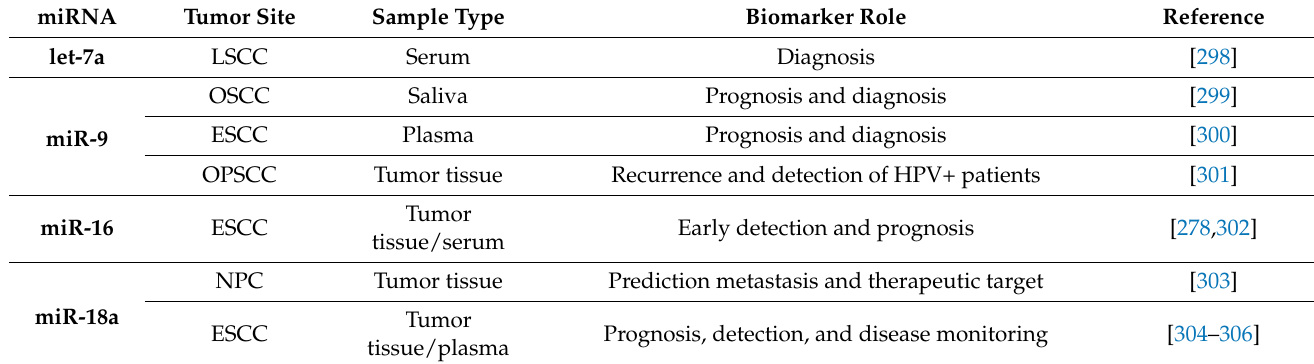
Table 1. Summary of the most common upregulated miRNAs reported as potential biomarkers in